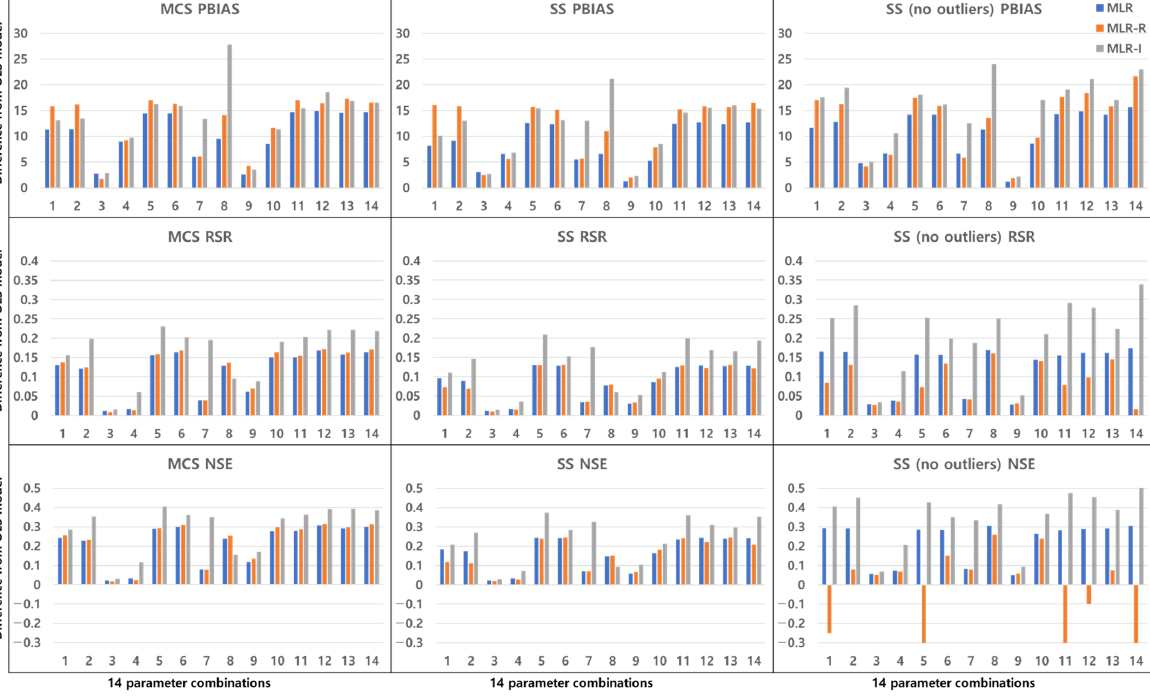
Figure 18. Differences between the OLS model and the other three MLR models by averaging the values of the model evaluations with the three sampling methods for TSS removal in retention ponds.